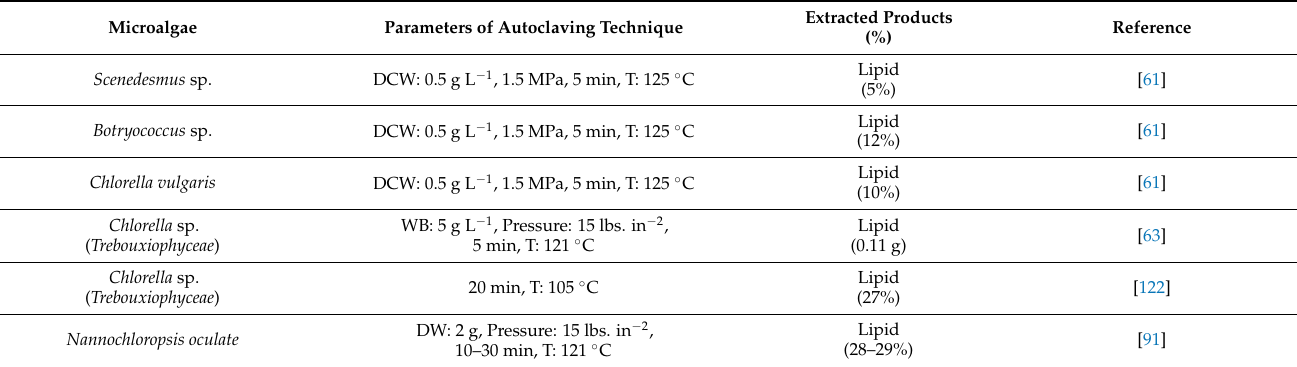
Table 4. Effects of the parameters of the autoclaving technique for the cell disruption of various types of microalgae. DW: dry weight; DCW: dry cell weight; WB: wet biomass; T: